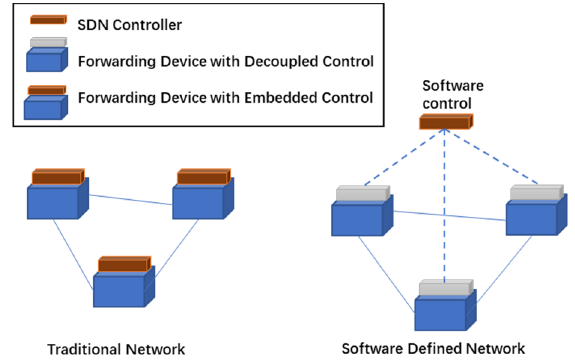
Figure 1. Decoupled control in SDN vs. traditional network.